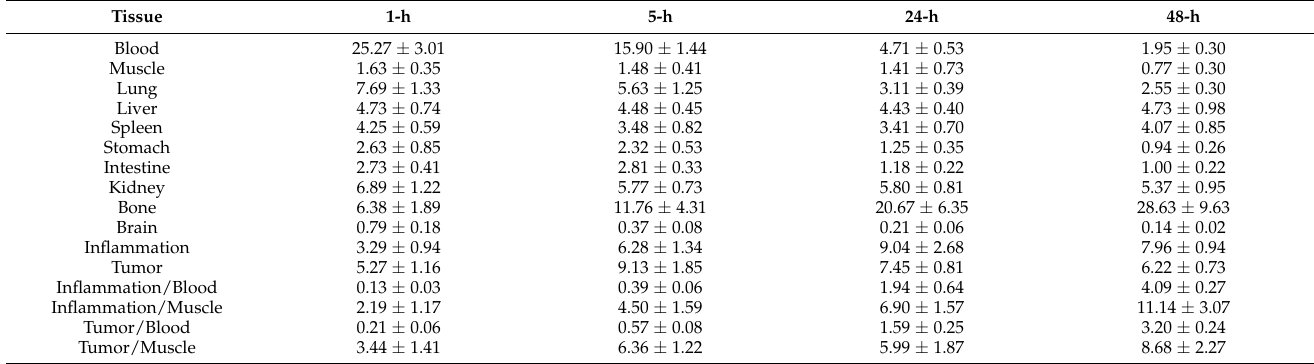
Table 1. Biodistribution data (%ID/g) of 89 Zr-oxalate in the tumor and inflammation models.